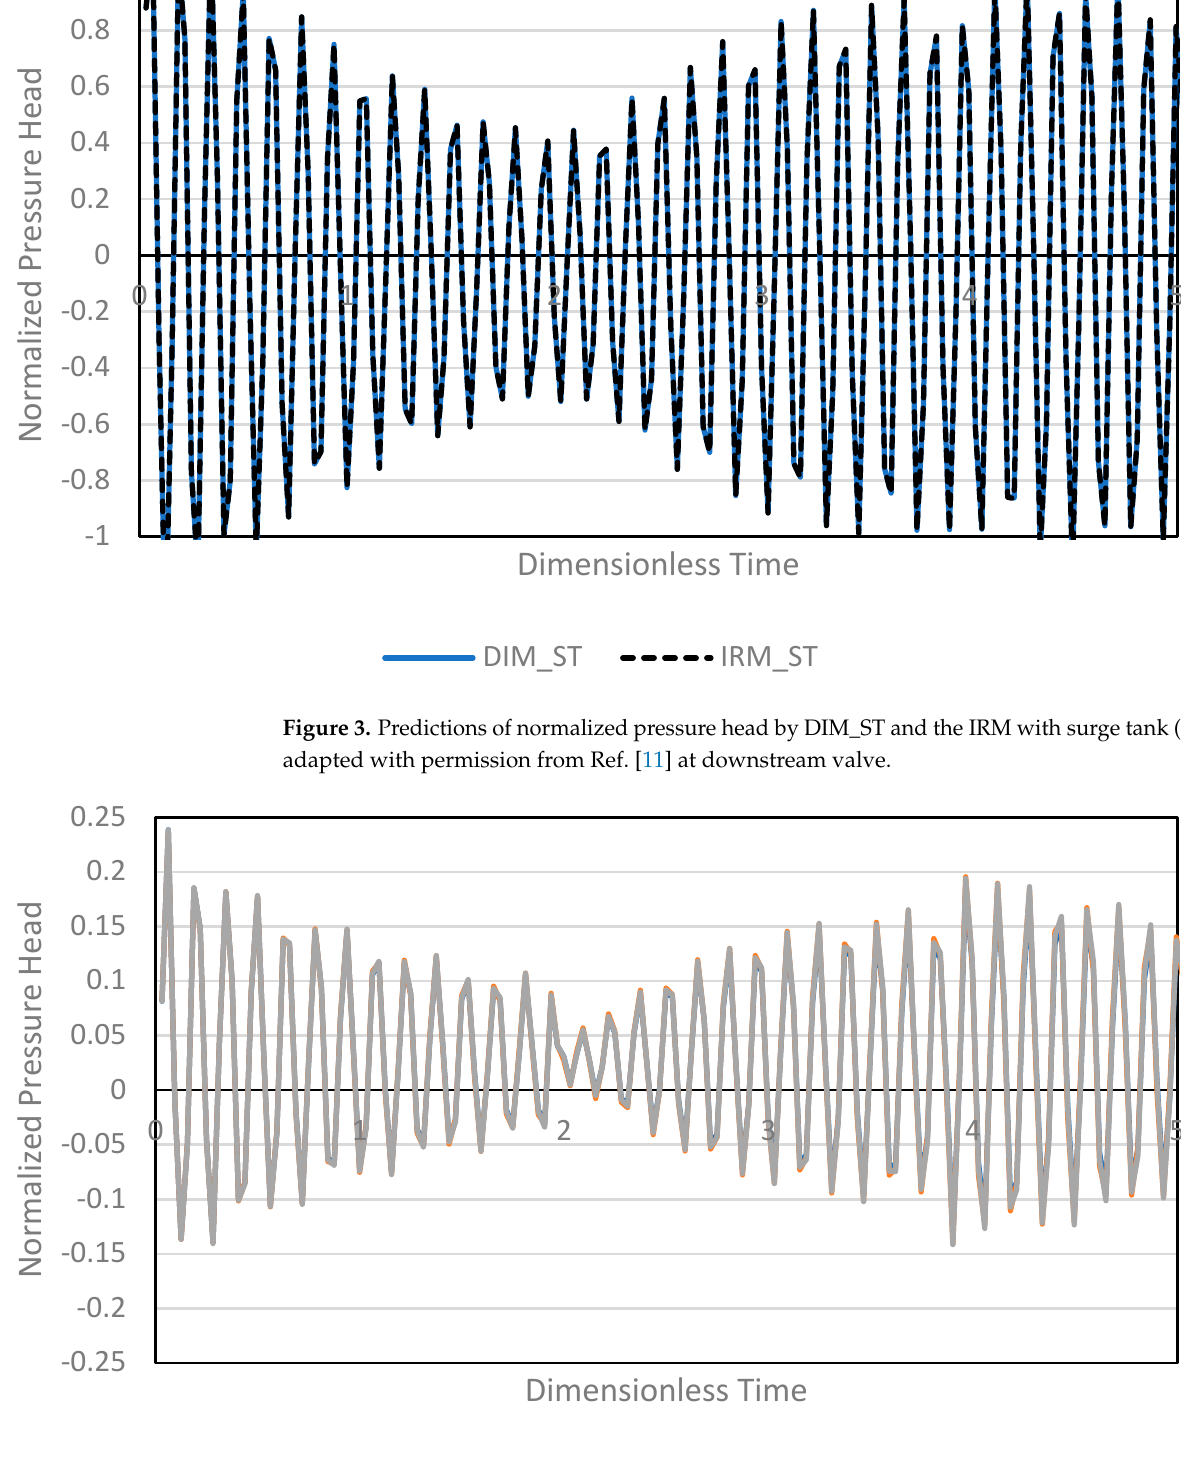
Figure 4. Predictions of normalized pressure head by DIM_ST using Equation (28), the dimension- less lumped inertia (DIM_ST_L) using Equation (33), and the conventional pipeline scheme for the connector (DIM_ST_C) using Equation (29) at the surge tank connector in the main pipeline . 3.2. Optimum Dimensionless Design of RPSPV Systems The flow regime of RPSPV systems can be comprehensively addressed by the dimen- sionless resistance (see Equations (5) and (6)), which means that a general design of the RPSPV system can be achieved through the application of the developed method for phys- ically meaningful bounds in 𝑅(cid:3552) . Considering the dimensions and materials of pipelines and